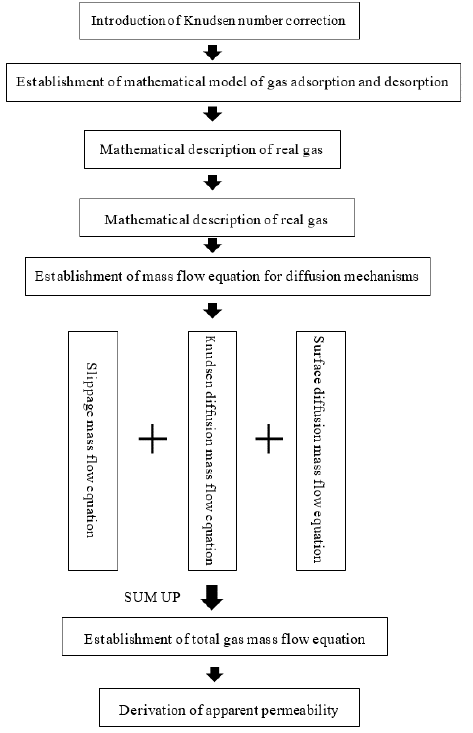
Figure 1. Flowchart of permeability model